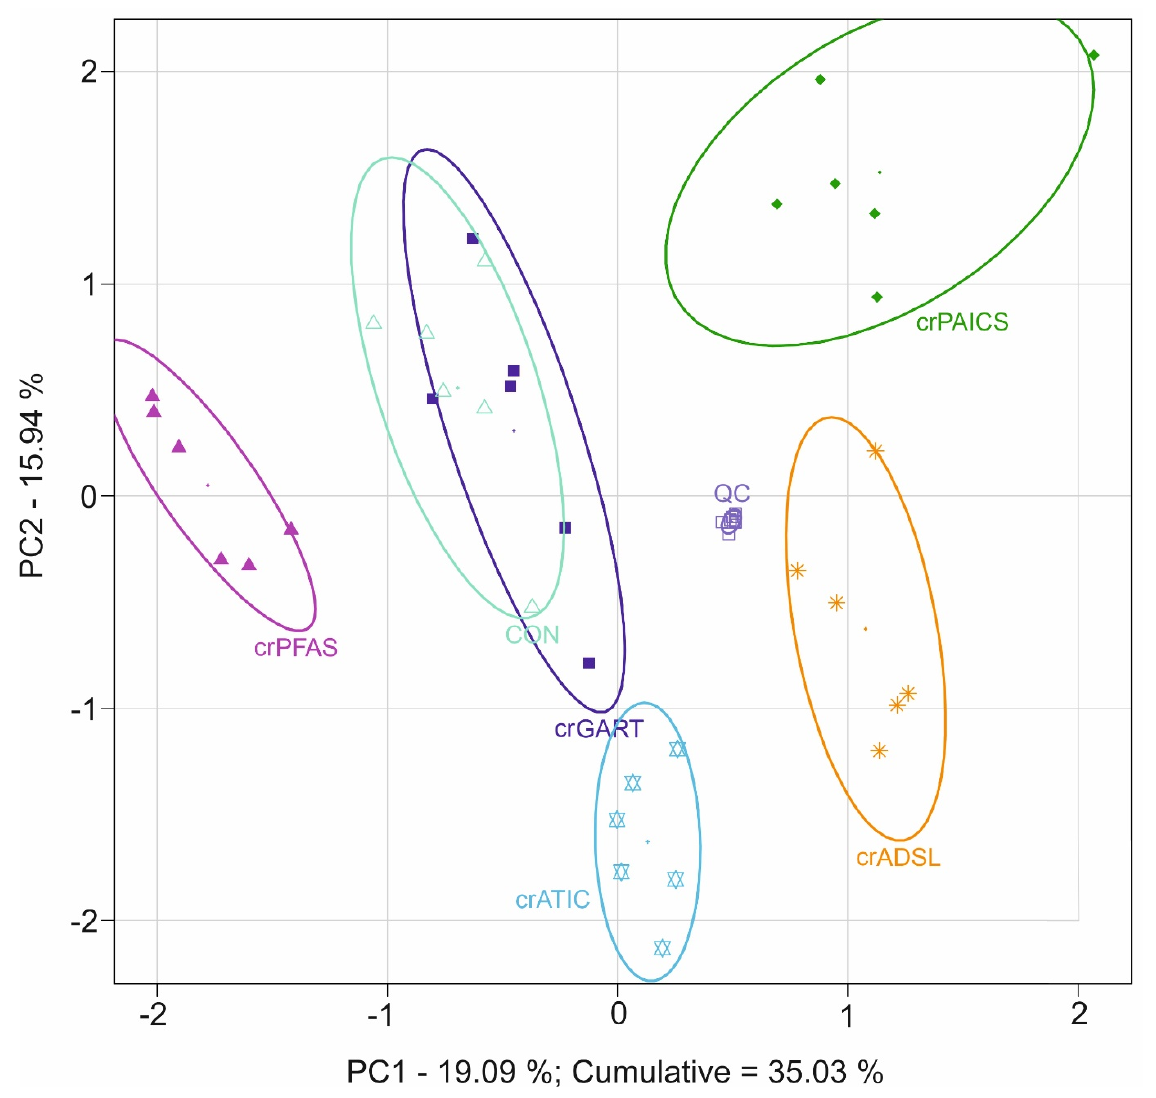
Figure 1. Principal component analysis of HeLa deficient and control cells that were subjected to an untargeted metabolomic analysis. Full line ellipses represent a 75% confidence interval. Congruence of crGART cells with control cells is caused by the lack of accumulation of primary metabolite in the pathway due to chemical instability; see Section 4.1 Untargeted metabolomics. Symbols: crGART cells (dark blue ■), crPFAS cells (purple ▲ ), crPAICS cells (dark green ♦ ), crADSL cells (orange ∗ ), crATIC cells (light blue ✡ ), control cells (light green △), QC samples ( grey □ ).